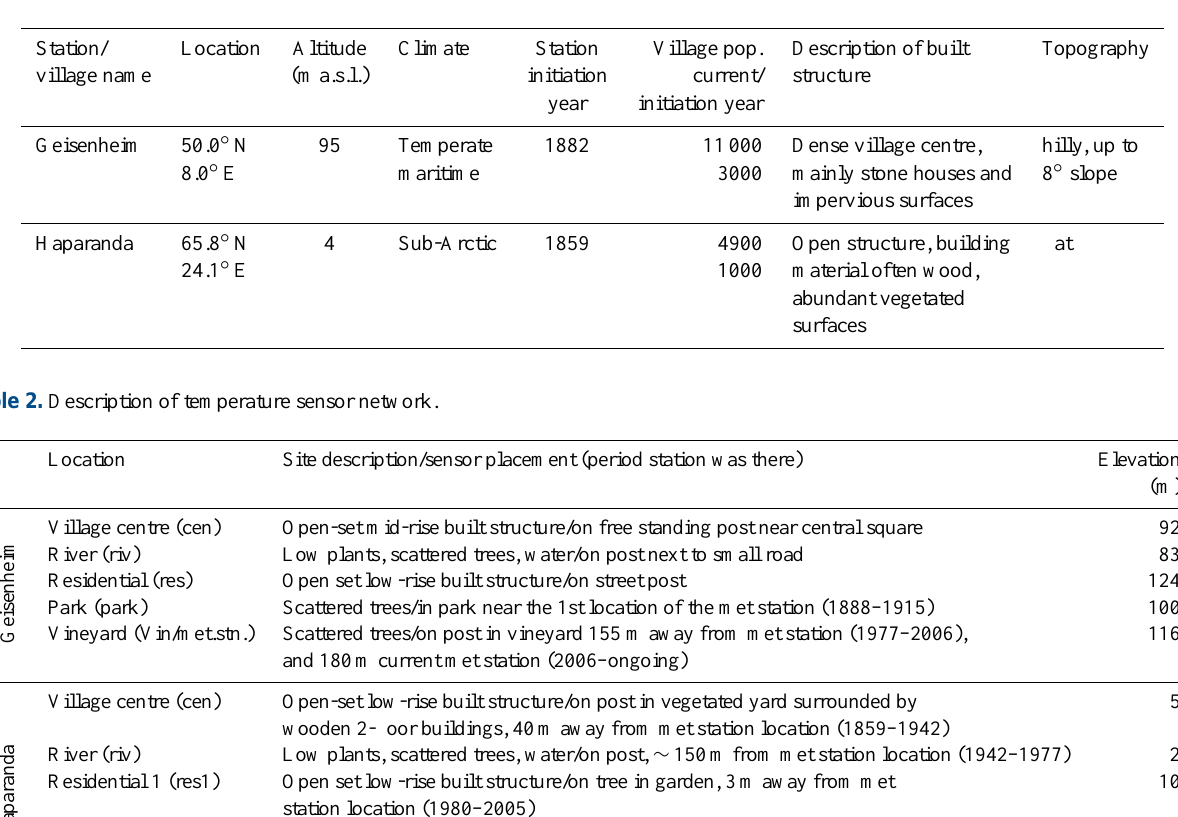
Table 1. Description of examined met stations and associated village. Source of data are the meta-data archives of DWD (Deutscher Wetterdi- enst, Klima und Umwelt, Climate Data Centre, Frankfurter Straße 135, 63067 Offenbach, Germany) and SMHI (SMHI, Folkborgsvägen 17, 60176 Norrköping, Sweden).